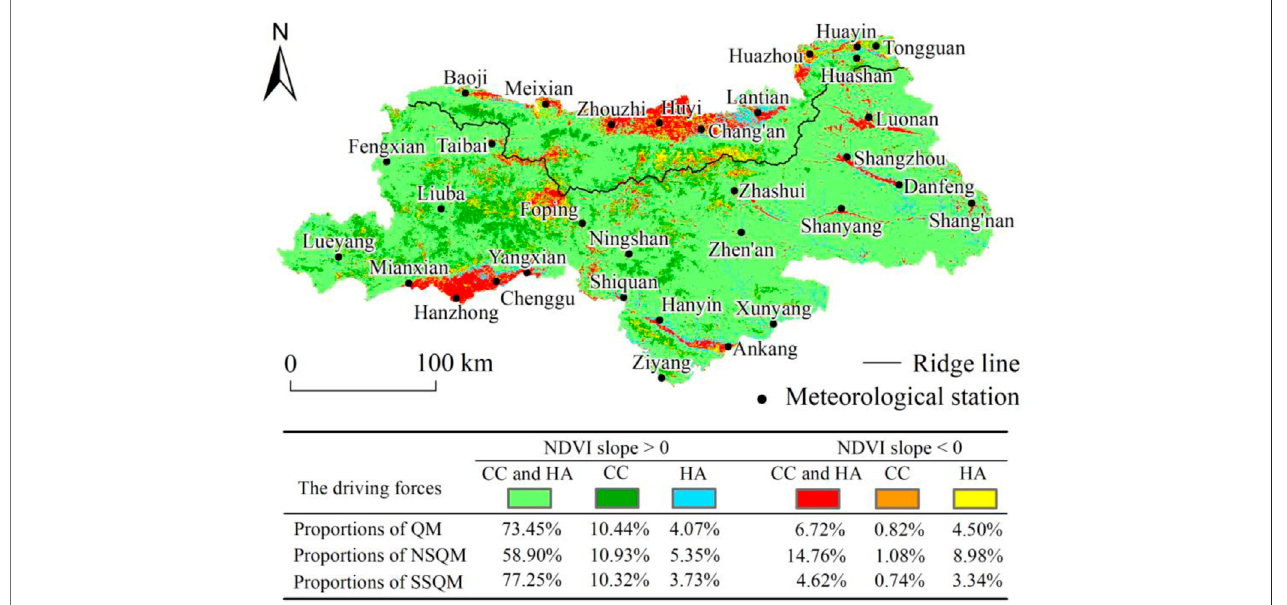
FIGURE 5 | Drivers of vegetation cover change in the Qinling Mountains during 2000 – 2019.